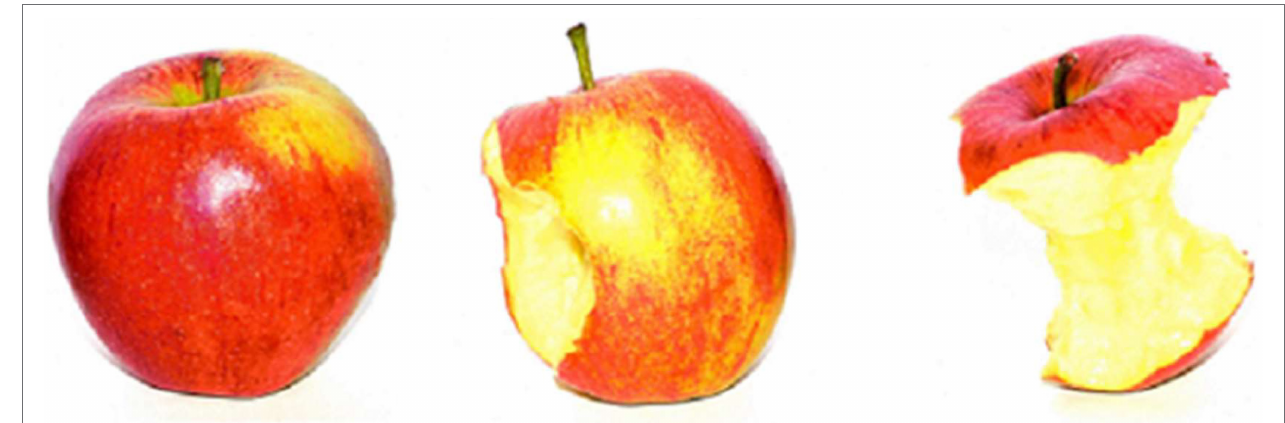
FIGURE 1 | Examples of materials used in Experiment 1. The three images are (from left to right): a whole apple (the “early” time point), a half-eaten apple (the “middle” time point), and an apple core (the “late” time